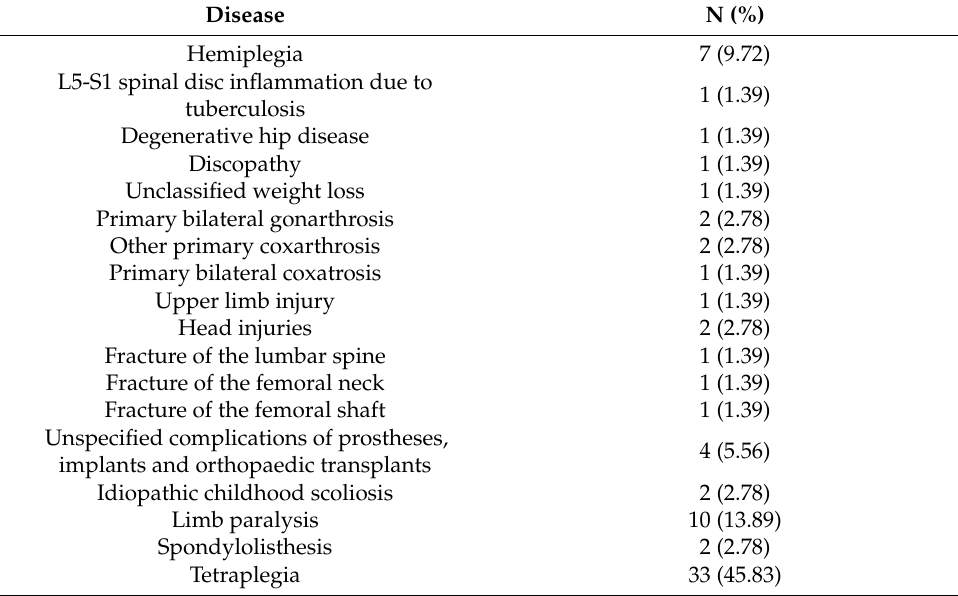
Table 2. Basic diseases and the number of detected nosocomial